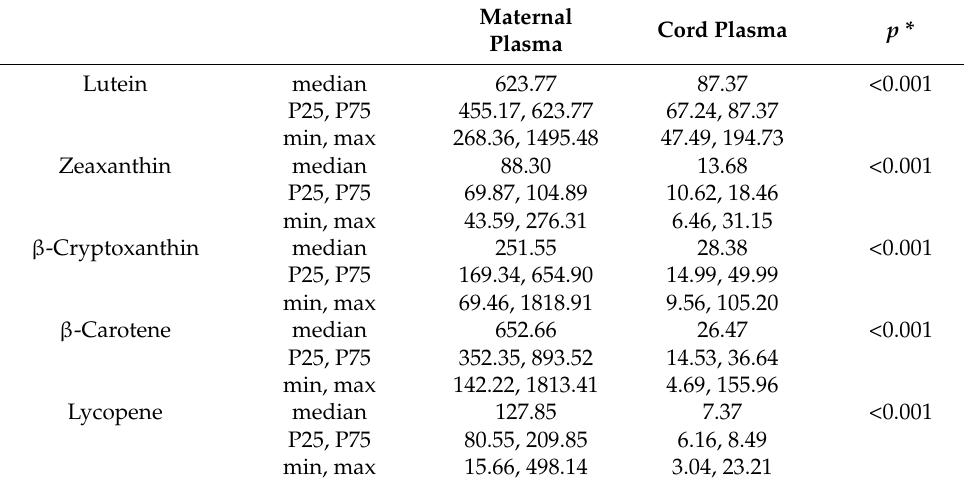
Table 2. Carotenoid levels ( µ g/L) in plasma ( n = 30).